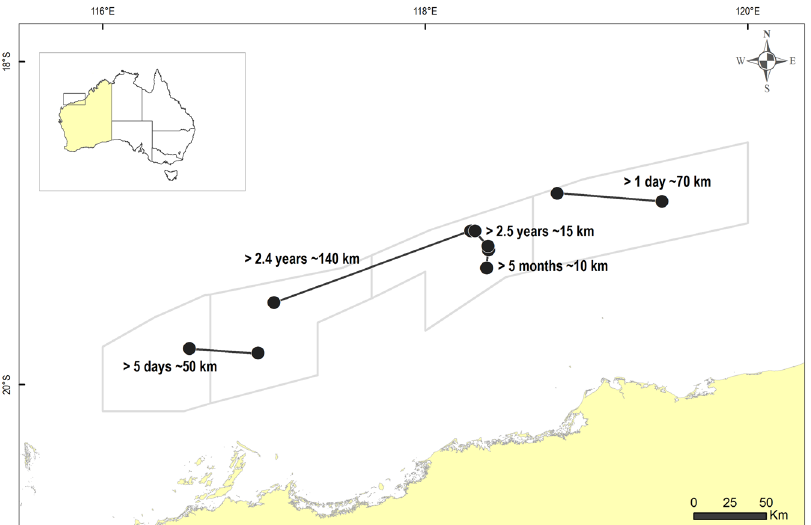
Figure 3. Locations, times and distances between repeat biopsy-sampling events of the same five bottlenose dolphin ( Tursiops truncatus ) individuals (revealed by genetic identity analyses based on microsatellite data) taken at least one day following initial sampling; Lines join circles representing the same individuals (n = 5). This figure was generated in ArcGIS